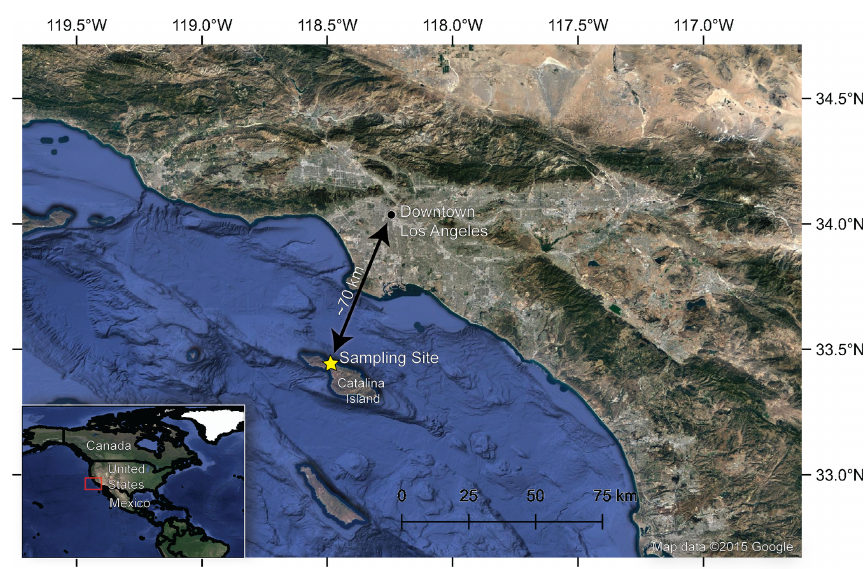
Figure 1. Overview map showing the location of the sampling site with respect to the Greater Los Angeles (LA) area. Map data © Google